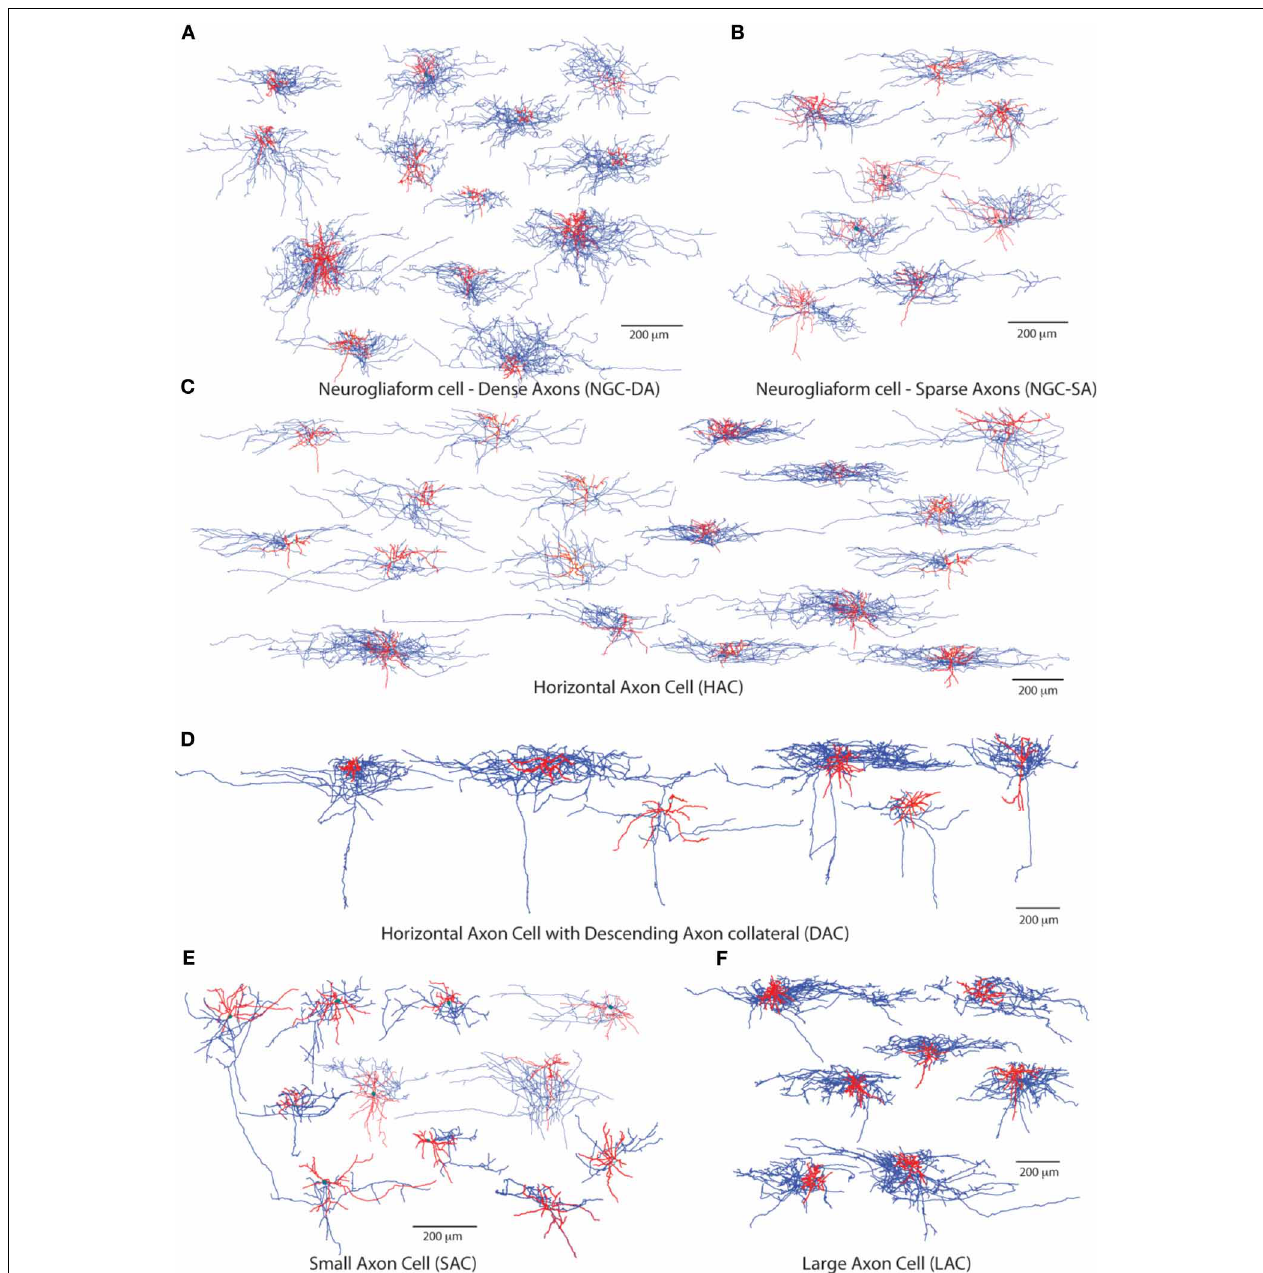
FIGURE 1 | Subjective Morphological types of cells found in L1. The 6 major morphologically distinct groups of L1 cells. (A) Typical neurogliaform cells with dense axonal arbourisation (NGC-DA). (B) Atypical neurogliaform